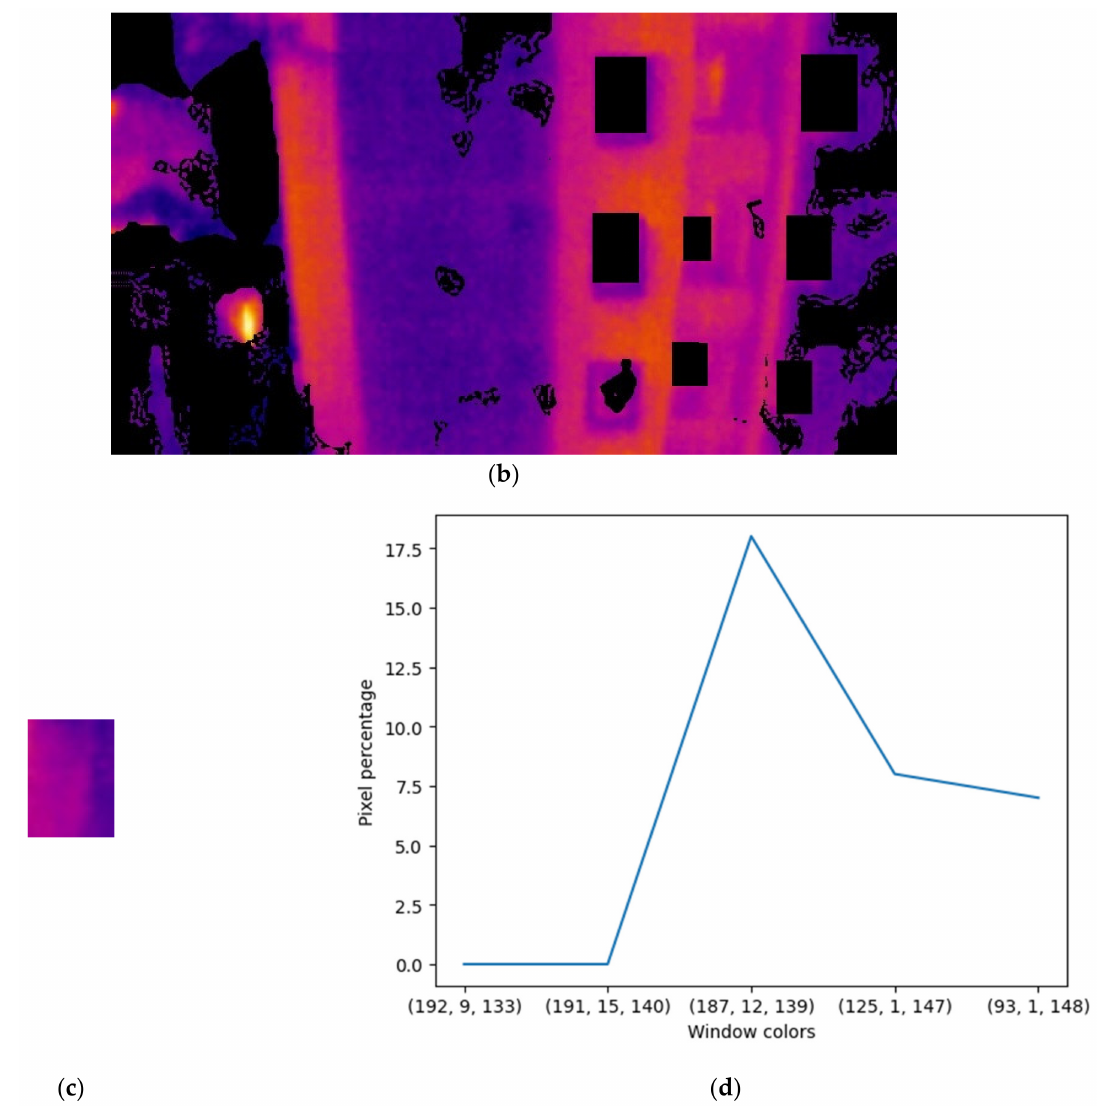
Figure 6. ( a ) Optical image with detected windows; ( b ) extracted windows and partly removed background; ( c ) segregated window; ( d ) window color distribution.